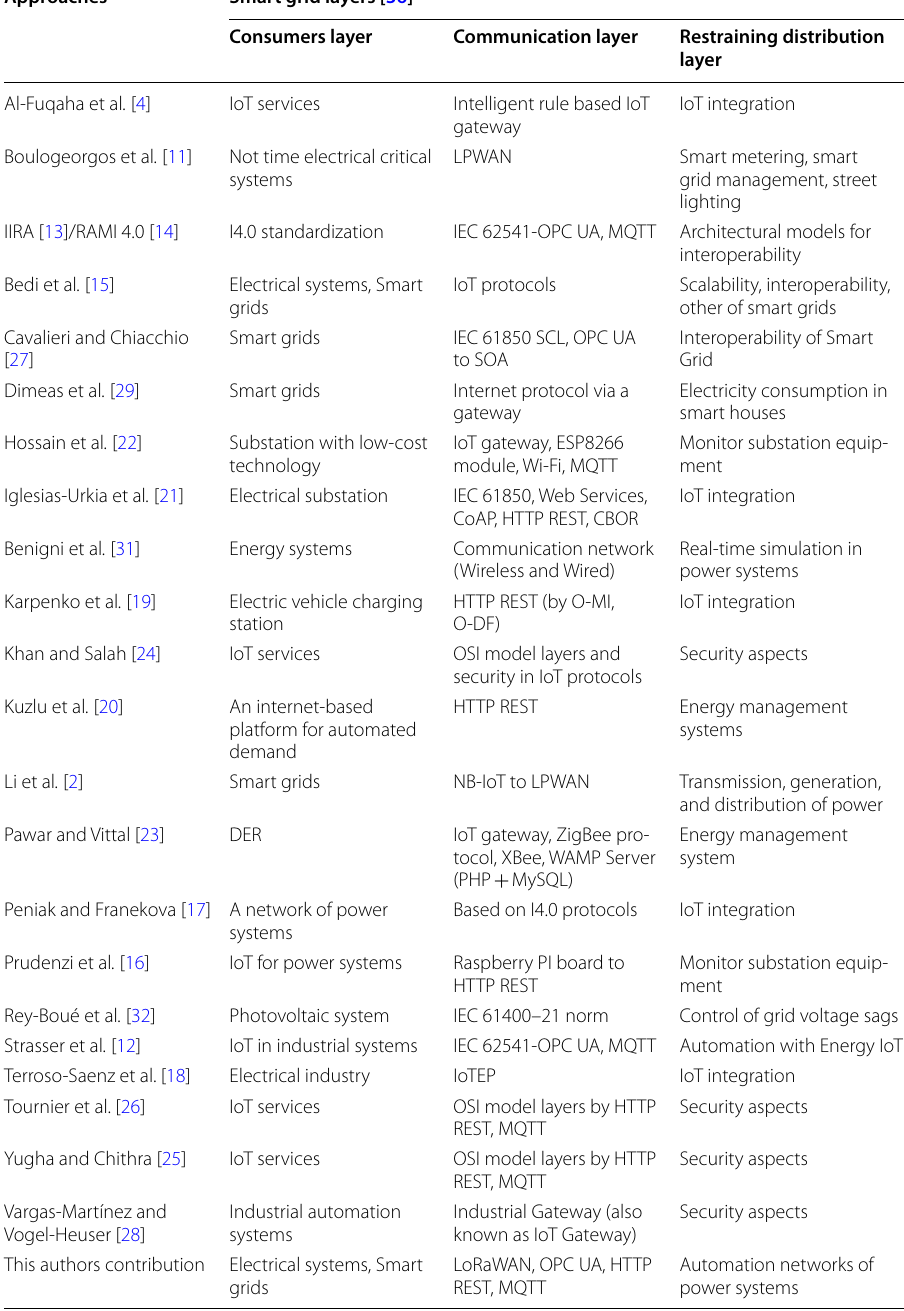
Table 1 Summary of the selected literature review of Smart grids